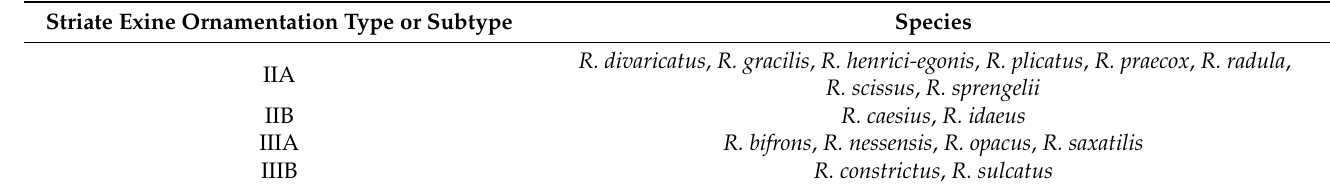
Table 6. Exine ornamentation types and subtypes of Rubus species studied (according to Ueda and Tomita [40]